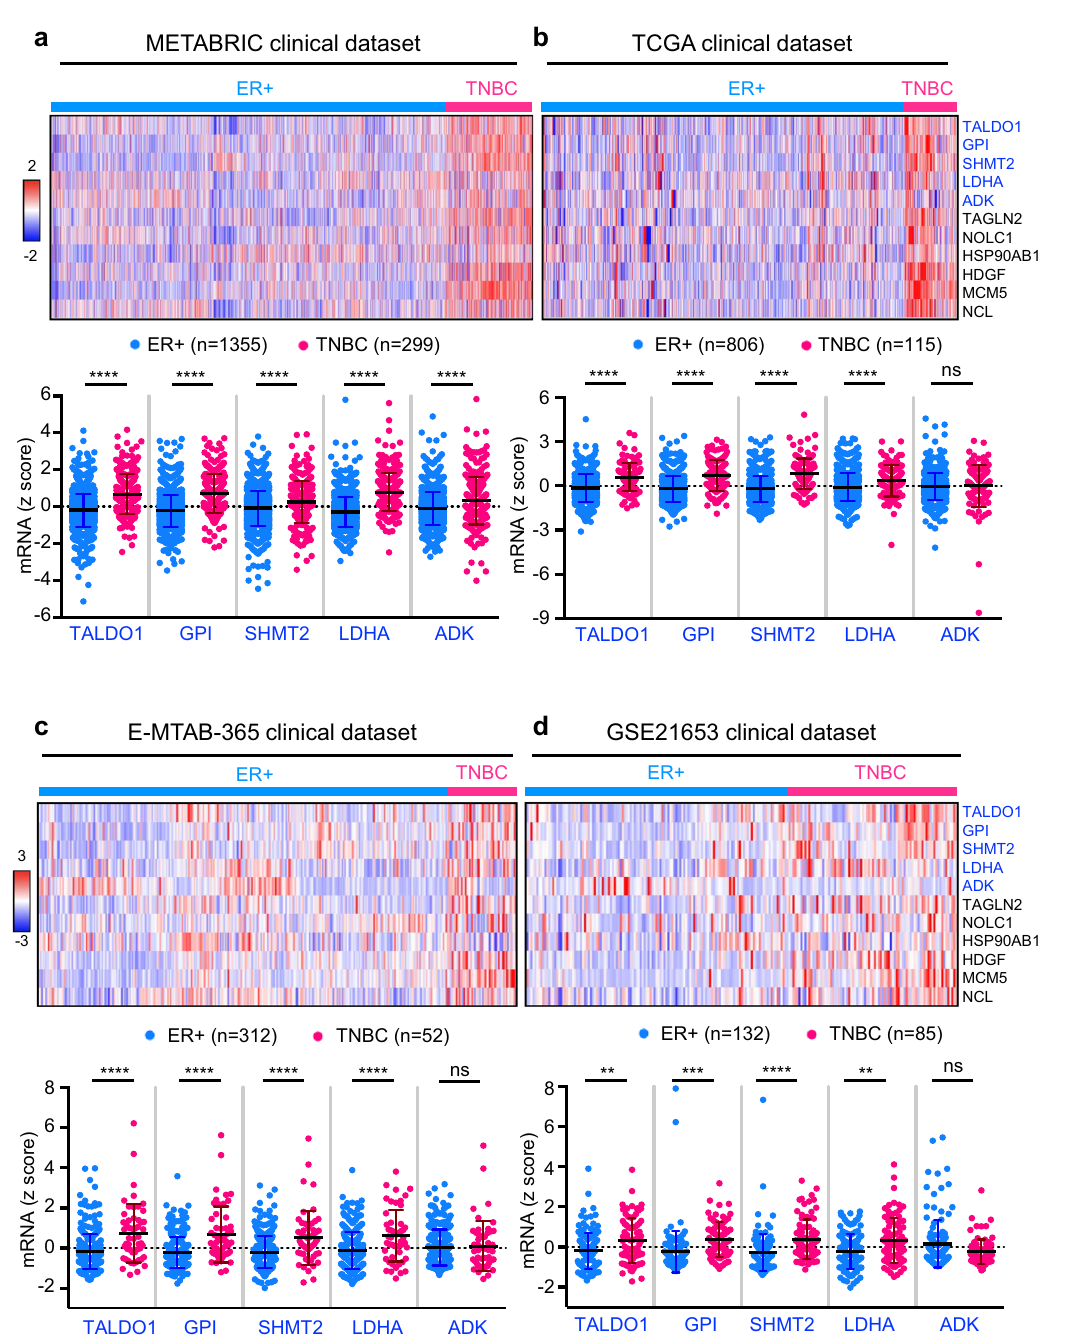
Fig. 4 Five-gene metabolic signature is enriched in TNBC patients when compared to ER + breast cancer patients. a – d Heatmap displaying mRNA levels of Trop2 associated 5-gene metabolic signature (TALDO1, GPI, SHMT2, LDHA, and ADK) and known oncogenes (TAGLN2, NOLC1, HSP90AB1, HDGF, MCM5, and NCL) in breast cancer patient samples (upper panel). The red color indicates a higher z -score whereas blue represents a lower z -score. Individual gene expression levels (TALDO1, GPI, SHMT2, LDHA, and ADK) are presented as dot plots (lower panel). The mRNA levels of the identi fi ed 5-gene metabolic signature in METABRIC 57 and TCGA (Firehose Legacy) clinical datasets are obtained from cBioPortal for Cancer Genomics (https://www.cbioportal.org/) 58,59 . The mRNA levels of the identi fi ed 5-gene metabolic signature in E-MTAB- 365 60 and GSE21653 61 clinical datasets are shown. Error bars represent standard deviation. Adjusted P value was calculated based on Bonferroni testing in Prism software. ** P < 0.01, *** P < 0.001, **** P < 0.0001, and ns not signi fi